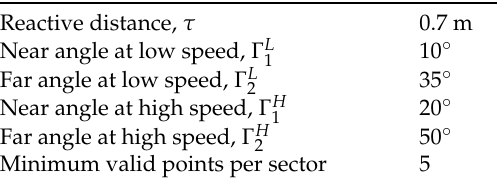
Table 5. Obstacle avoidance configuration.